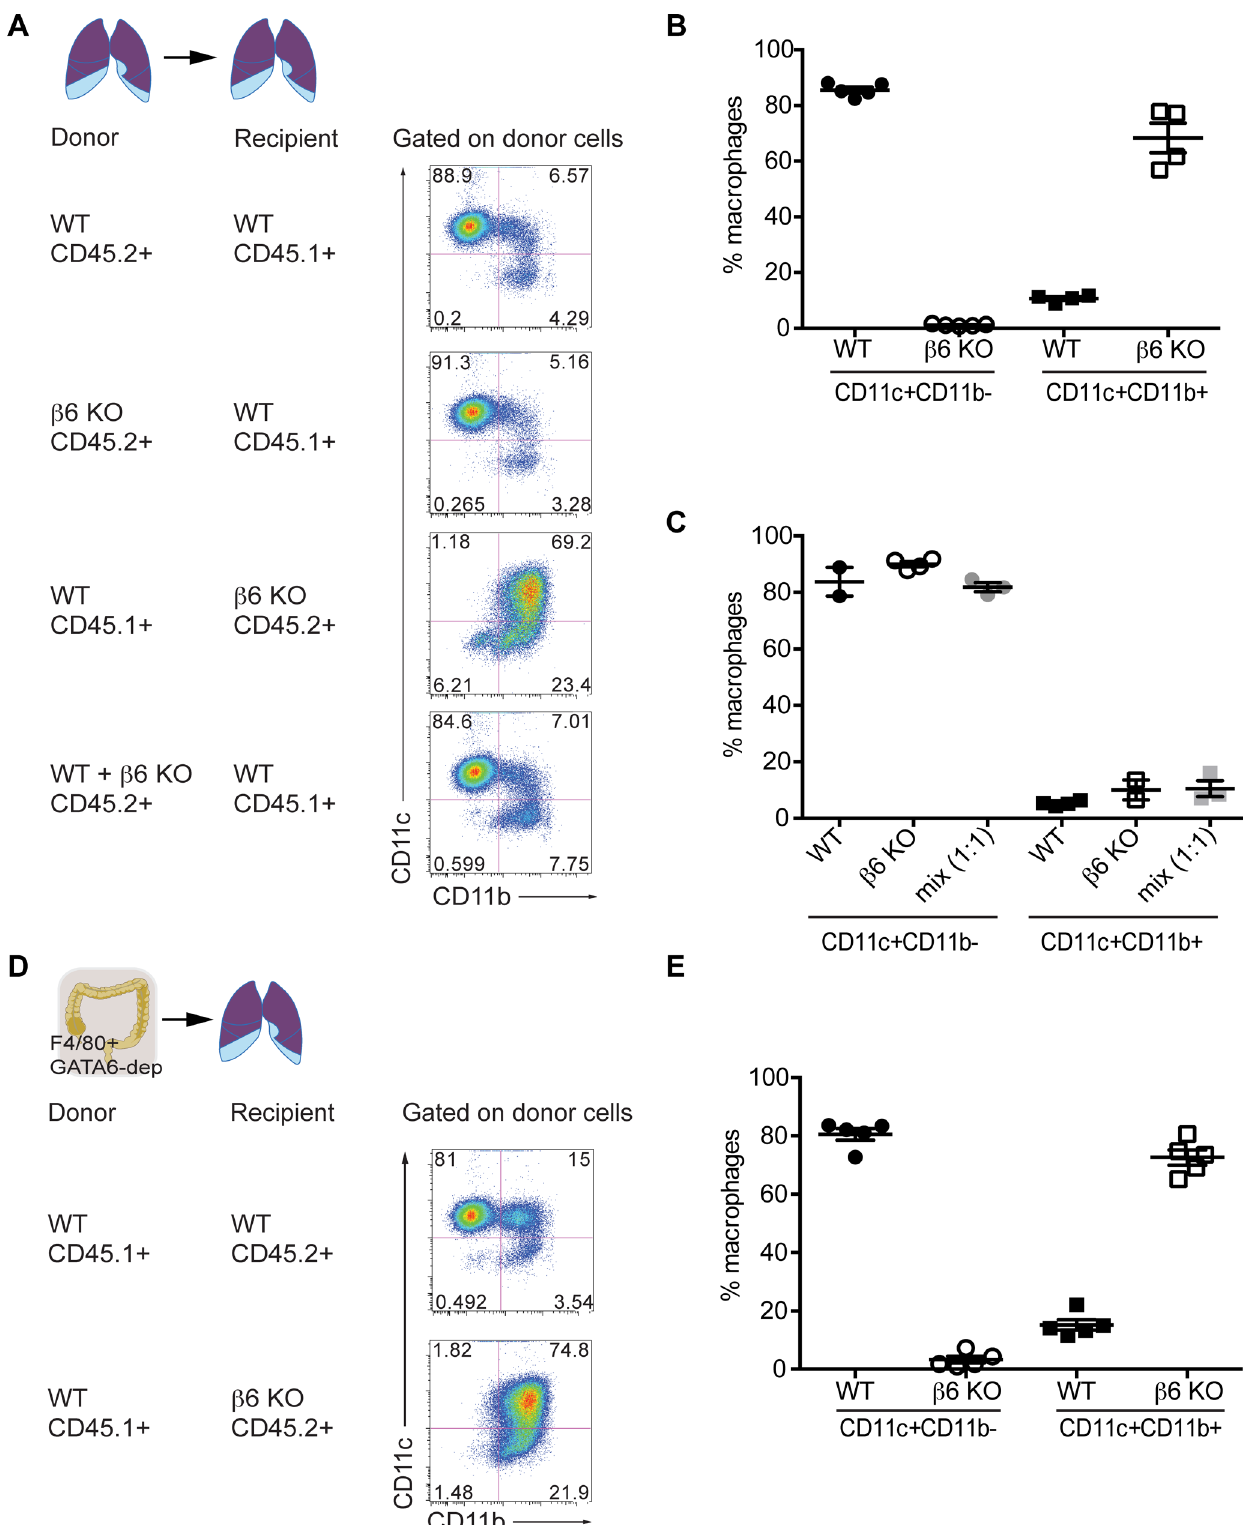
Fig 6. Macrophage phenotype is defined by the pulmonary microenvironment. (A) Uninfected WT (littermate controls) or β 6 KO mice were inoculated intratracheally with alveolar macrophages (AM) isolated from WT or β 6 KO mice. CD45.1 or CD45.2 markers identified donors and